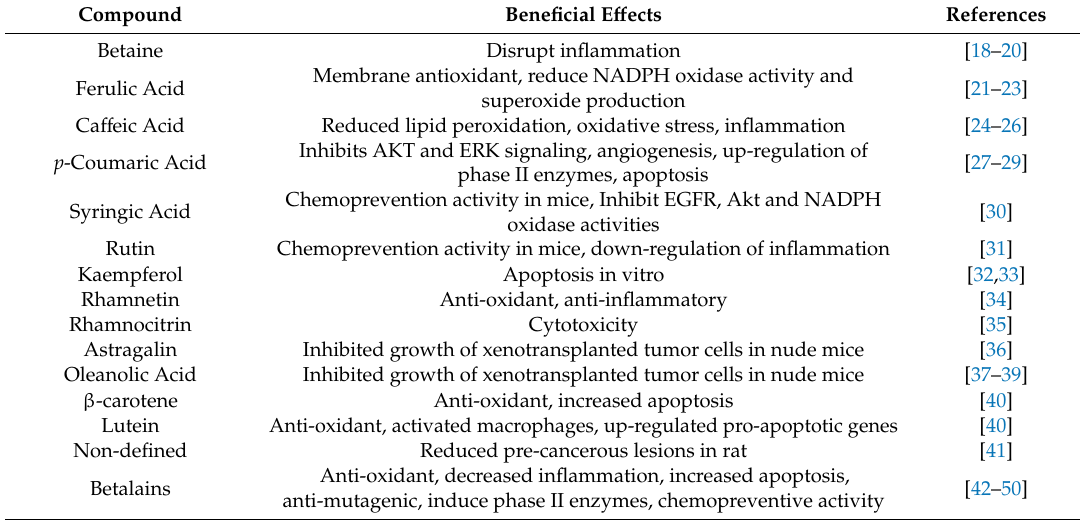
Table 1. Compilation of Bio-reactive Compounds in Red Beetroot with Cancer Chemopreventive Activity. Compound Beneficial E ff